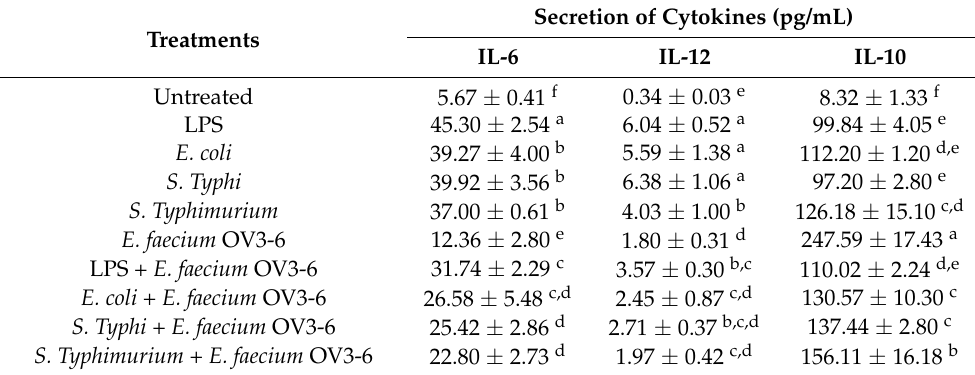
Table 1. Secretion of cytokines by Caco-2 when treated with LPS, E. coli , S. Typhi , S. Typhimurium , and E. faecium OV3-6.